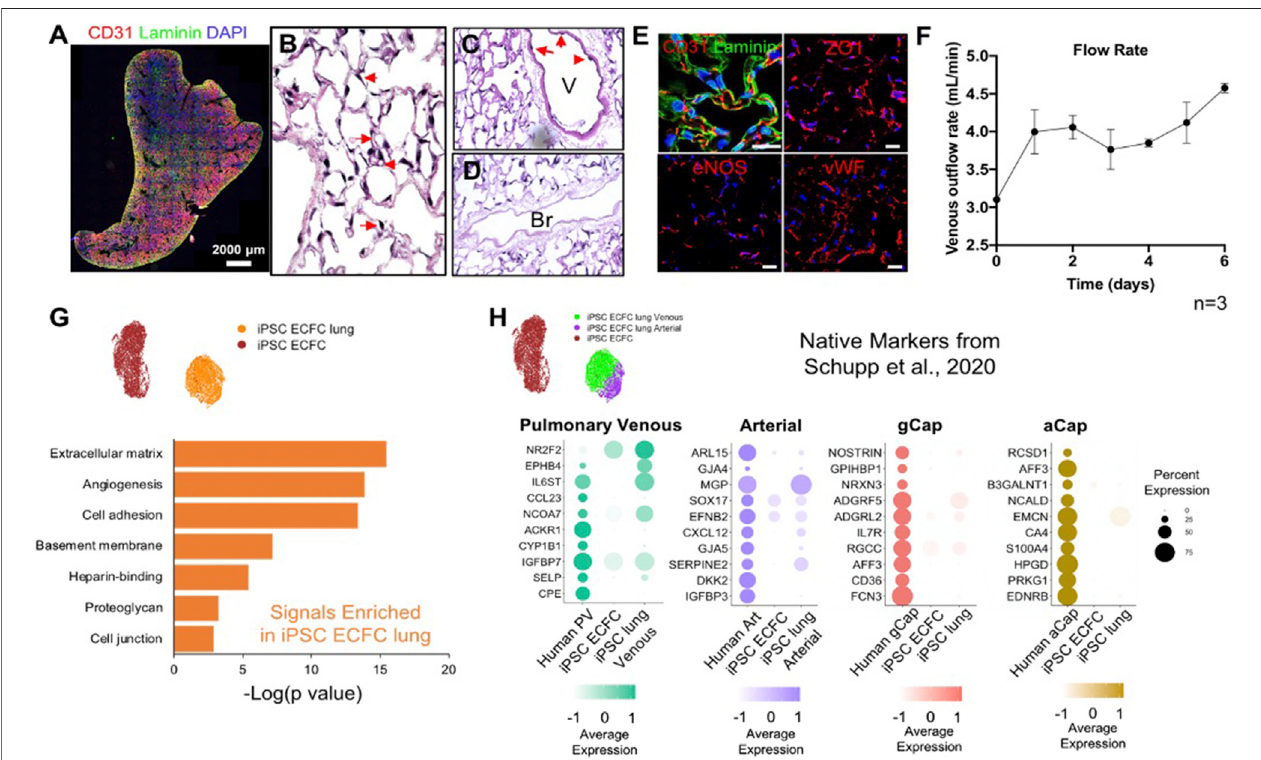
FIGURE 5 | Human iPSC-ECFCs start to gain native EC phenotype in repopulated lungs. (A) Immunostaining of CD31 and Laminin in iPSC-ECFC-repopulated lungs. Scale bar 2,000 μ m. (B – D) H/E image of a representative section iPSC-ECFC repopulated lungs. Arrows in (B) point to reconstituted capillary lumens; arrows in (C) point to endothelial cells in the vasculature but not in bronchia. V: Blood Vessel; Br: Bronchi (E) Immunostaining for CD31, laminin, ZO1, eNOS, and vWF in repopulatedlungs,scalebar20 μ m. (F) Venousout fl owsversustime, n (cid:1) 3. (G) GeneontologyanalysisofthetopDEGs( p < 0.05)enrichediniPSC-ECFClungsas compared to pre-seeded iPSC-ECFCs. (H) Dot plots show the comparison for top 10 select native markers of human pulmonary venous, arterial, gCap, and aCap amongst native human lung endothelium, pre-seeded iPSC-ECFCs, and iPSC-ECFC-repopulated lungs. Samples were merged and